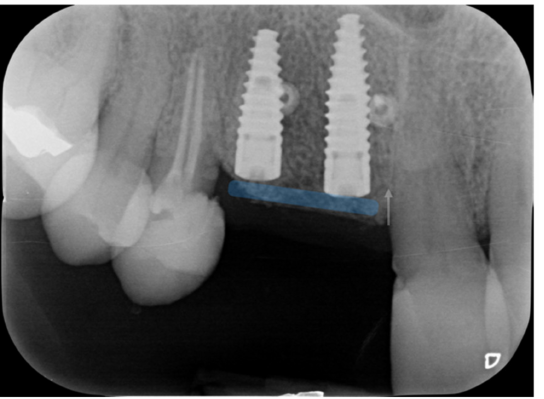
Figure 19. Soft tissue sculpting.